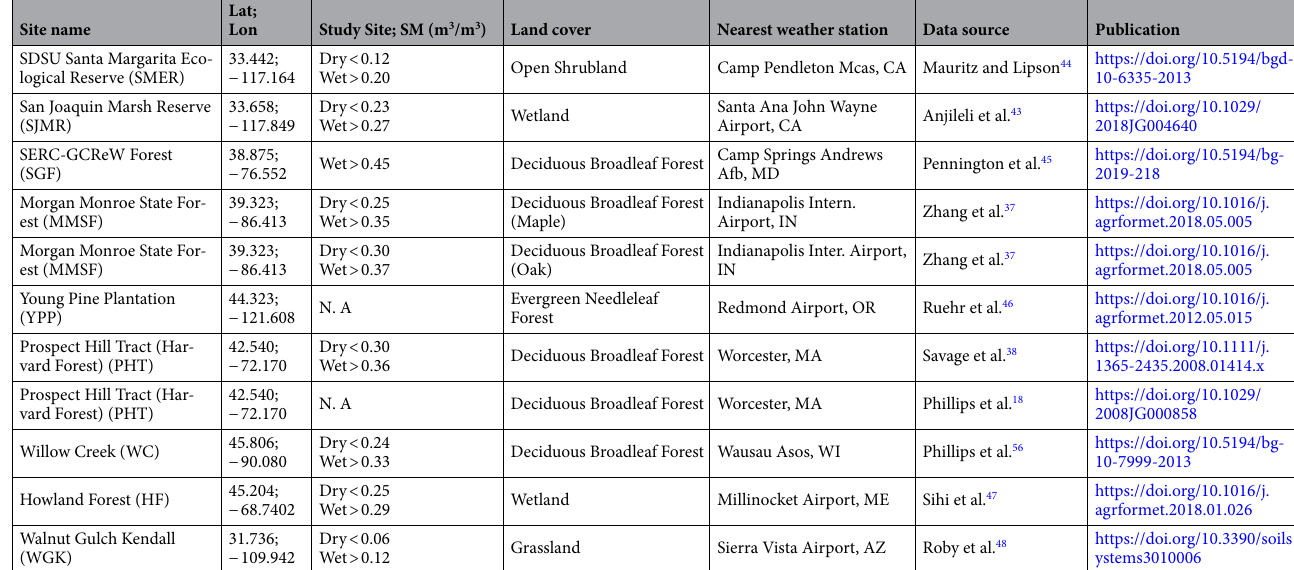
Table 1. Study sites for continuous soil respiration observation obtained from